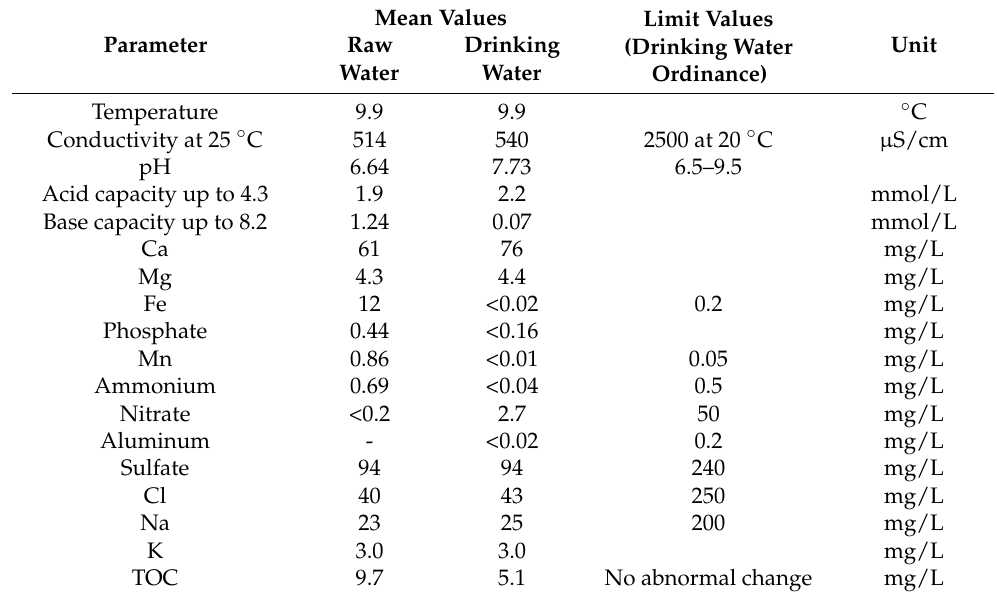
Table 1. Mean values of the various parameters for raw water and drinking water at the Fuhrberg waterworks with the specified limit values in the Drinking Water Ordinance. The parameters shown in gray are not taken into account in the modeling. Mean Values Limit Values Parameter UnitRaw Drinking (Drinking Water Water Water Ordinance) Temperature 9.9 9.9 ◦ C Conductivity at 25 ◦ C 514 540 2500 at 20 ◦